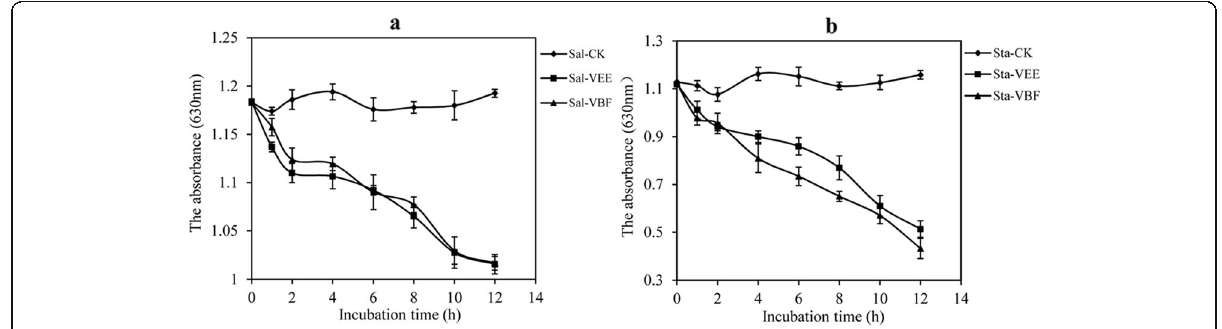
Fig. 4 Effects of VEE and VBF on the phosphorous metabolism of S. paratyphi A (Sal, a ) and S. aureus (Sta, b